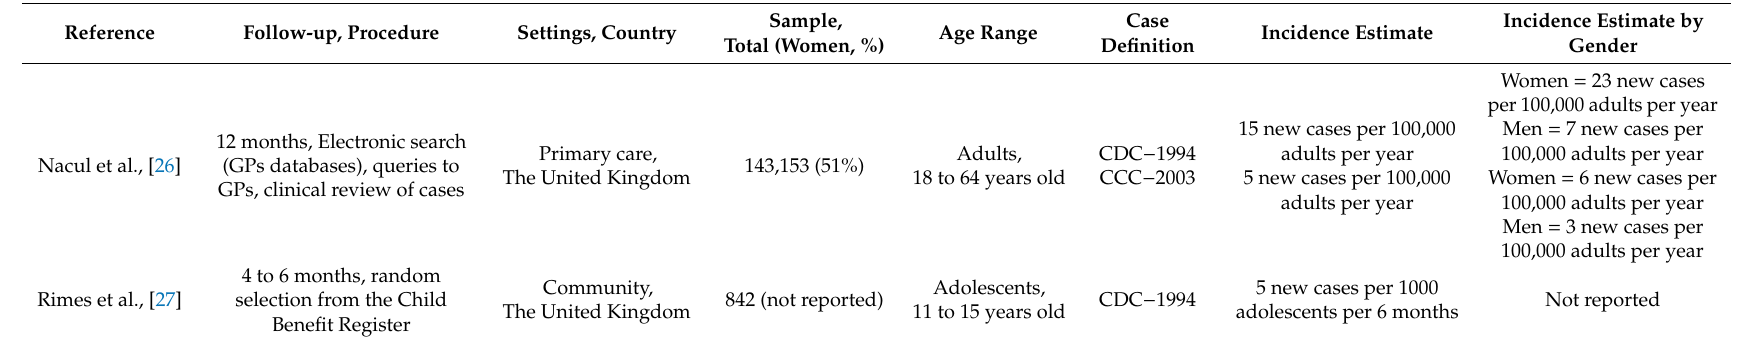
Table 2. Characteristics of the included studies reporting the incidence of ME / CFS in European